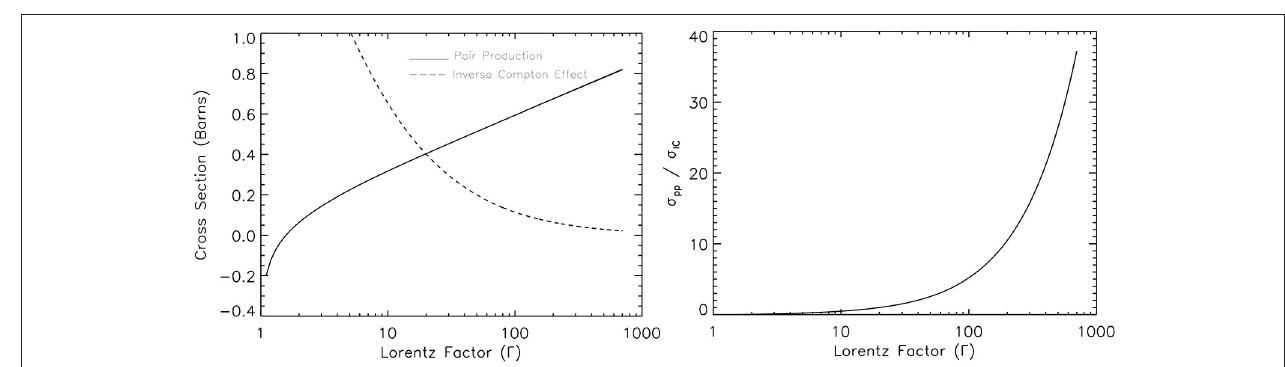
FIGURE 3 | Left: Theoretical cross sections obtained from our analytical model, for the inverse Compton effect and the electron-positron pair production as a function of the Lorentz factor. Right: Ratio of the cross sections of the two processes mentioned above as a function of the Lorentz factor. The model predicts that as the Lorentz factor increases significantly, there is a much higher probability of a pair production transition that can cause absorption of gamma-rays within a region of increasing Lorentz factor.